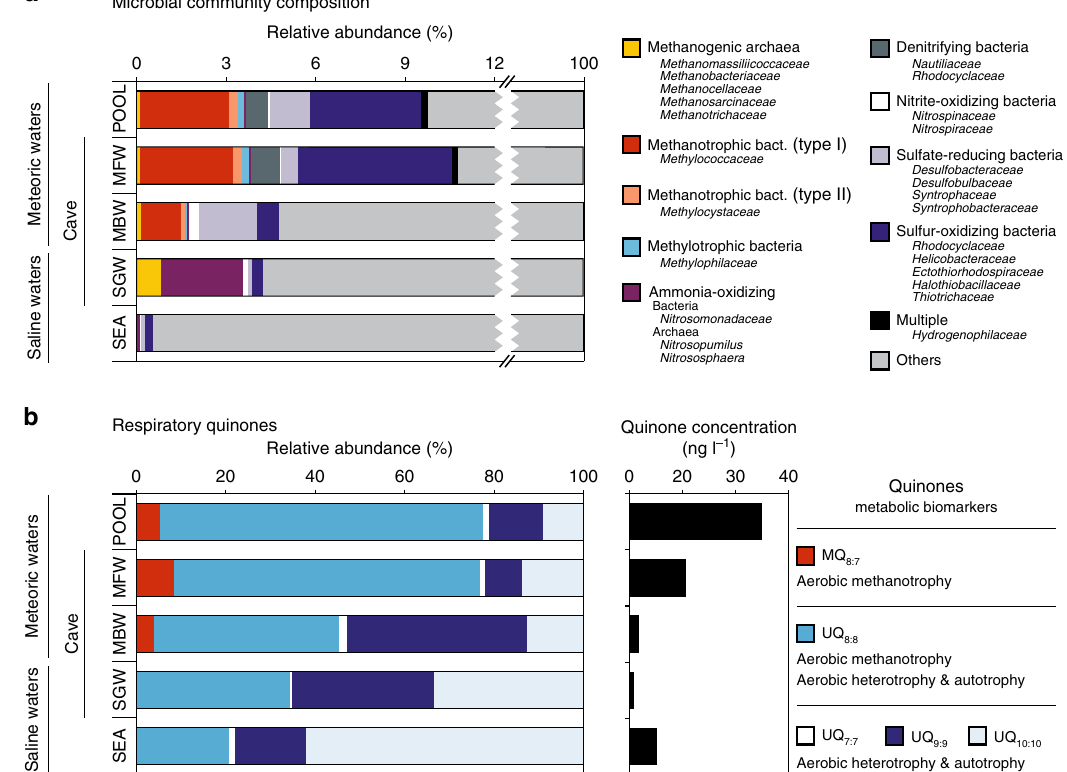
Fig. 4 Microbial community diversity within the subterranean and surface water regimes. a 16S rRNA amplicon sequence community analysis. Functional groupings are based on the presence of sequences shared by microbes that mediate the associated function. “ Multiple ” indicates there was no speci fi c function associated with the closest match type strain. The majority of sequences were from bacteria and archaea capable of utilizing a variety of complex organic compounds ( “ Others ” ; see Supplementary Fig. 4 for further details). For a comprehensive phylogenetic listing and relative abundance of sequence reads see Supplementary Data 2. b Respiratory quinones relative abundance, concentrations, and metabolic af fi liations. Quinone nomenclature (UQ m : n ) after Elling et al. 35 , where Q indicates headgroup type, m number of isoprenoid units in the side chain, and n number of double bonds. MBW,